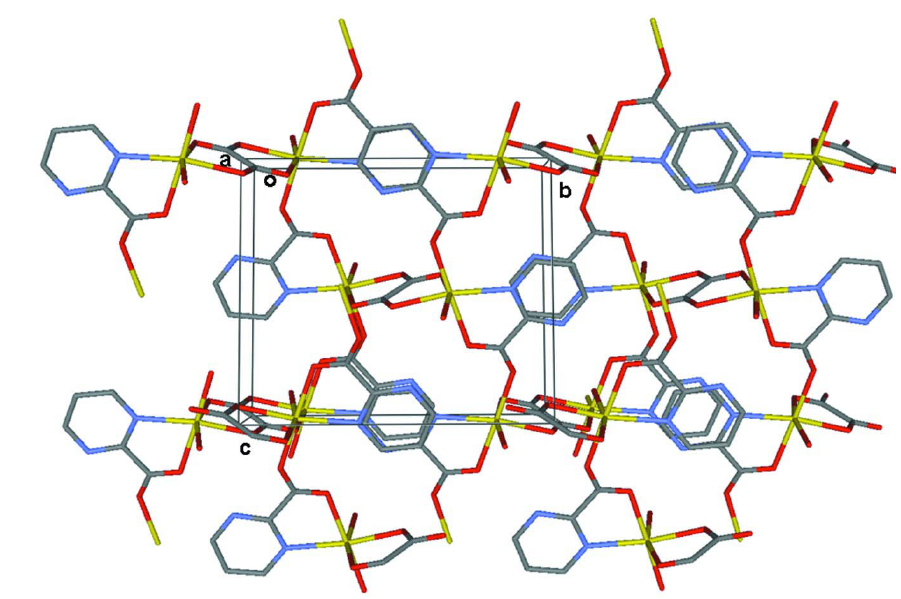
Figure 2 A view down the a axis of the crystal structure of [Mn atoms and the bidimensional (6,3) net topology. The H atoms have been omitted for